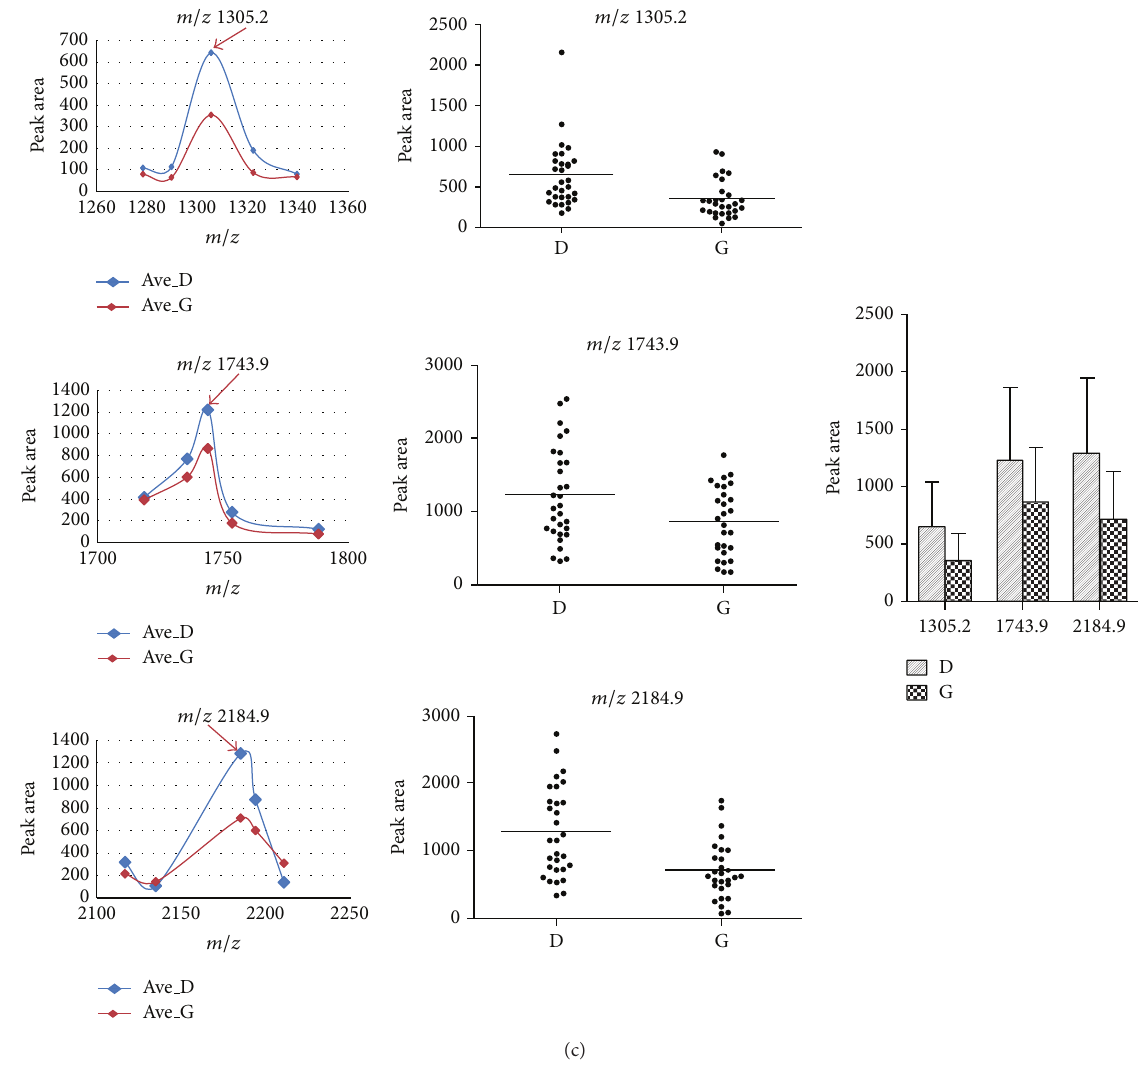
Figure 2: The feature of the 6 selected peaks in two groups. (a) The distribution of average peak area from two groups. (b) The average value of 3 elevated peaks in G group when compared with D group (left and right) and their distribution in all samples (middle). (c) The average value of 3 decreased peaks in G group when compared with D group (left and right) and their distribution in all samples (middle).